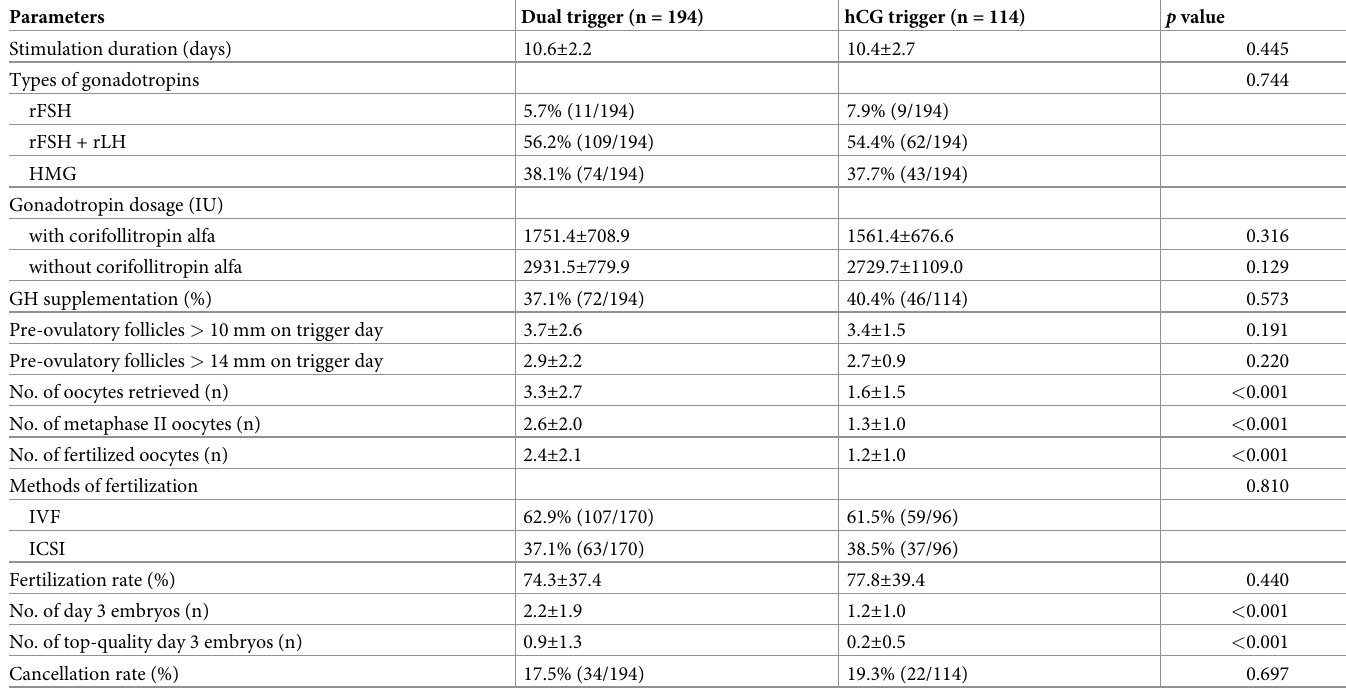
Table 2. Cycle characteristics of older patients with diminished ovarian reserve (POSEIDON group 4) with dual-trigger or hCG trigger. Parameters